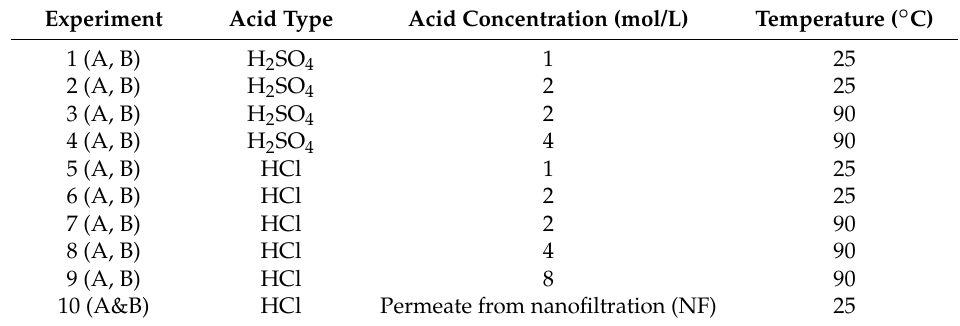
Table 1. Leaching of anode (A) and cathode (B) active materials. The experiments were performed under atmospheric pressure, s/L = 1/20 (g/mL), stirring rate = 500 rpm. Cathode and anode were leached separately.